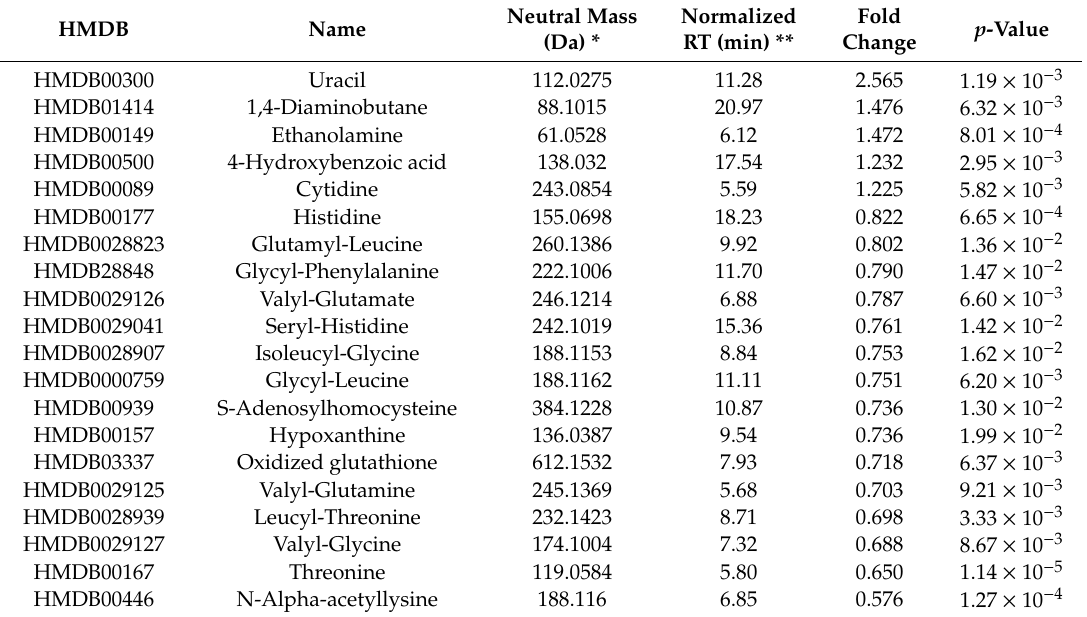
Table 5. Positively identified significantly di ff erentially expressed metabolites in the rat liver tissue after prolonged Dex